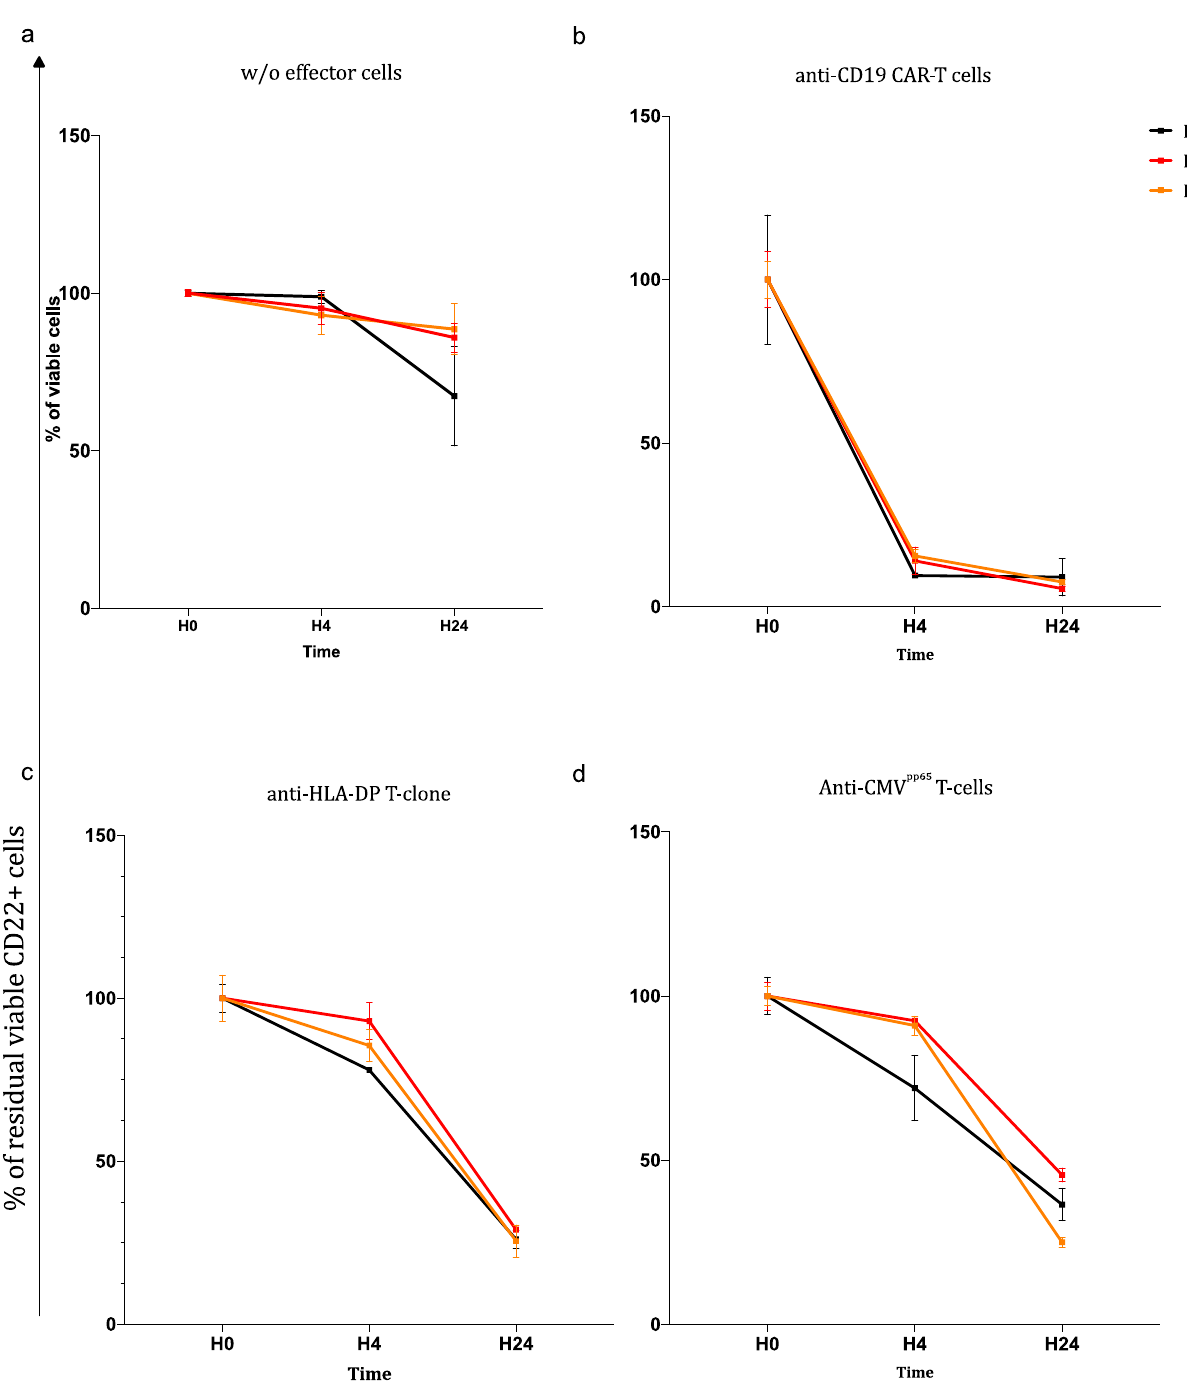
Figure 3. Long-term killing assays. Residual viable ALL cells at 3 time points of co-culture H0 (starting point), after 4 h (H4) of co-culture and after 24 h (H24) of co-culture: ( a ) with no effector, results showed total viable cells; ( b ) with a purified autologous anti-CD19 CAR-T cell preparation (percent of residual CD22+ viables cells); ( c ) with anti-HLA DPB1*04:01 CD4+ T-clone (percent of residual CD22+ viables cells); ( d ) with anti-CMVpp65 CD8 T-cells (percent of residual CD22+ viables cells). Two experiments in duplicate were performed at effector/ratio = 3:1. Results are given as mean + SD. CMVpp65 peptides: PepTivator CMVpp65 human, 130-093-435, Miltenyi Biotec; T eff: T-cell effectors, here polyclonal CD8+ T cells against CMV peptides.